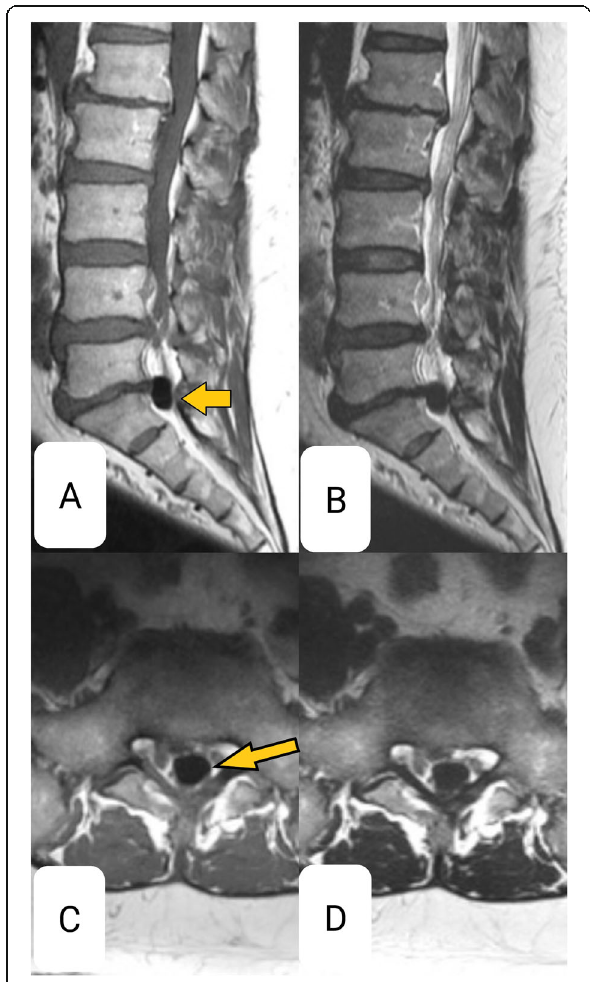
Fig. 2 MRI. Sagittal T1 ( a ) and T2 ( b ) and axial T1 ( c ) and T2 ( d ) weighted sequences show low-intensity signal in all the sequences in the epidural space compressing the cauda equina. Attenuated CSF signals seen in the spinal canal. Degenerative changes seen in multiple levels. Origin: © Department of Radiology, King